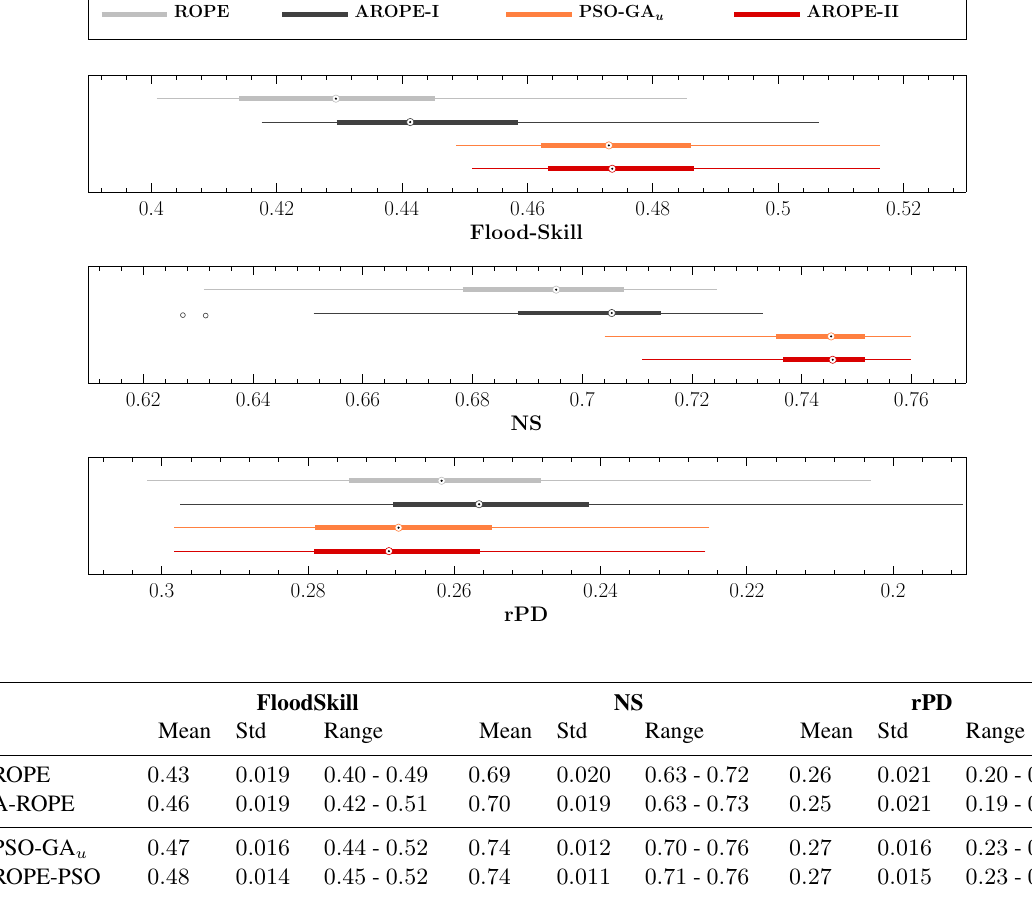
Fig. 16: Calibration performance for the parameter vectors estimated by ROPE, A-ROPE, PSO-GA u and ROPE-PSO. These results show the advantages of the depth parameters and an additional conceptual parameter based sampling, namely the possibility to filter out parameter vectors corresponding to a more volatile and consequently lower model performance. However a comparison of the Monte Carlo based algorithms (ROPE and A-ROPE) with the PSO based ROPE-PSO also show the limits of this approach.